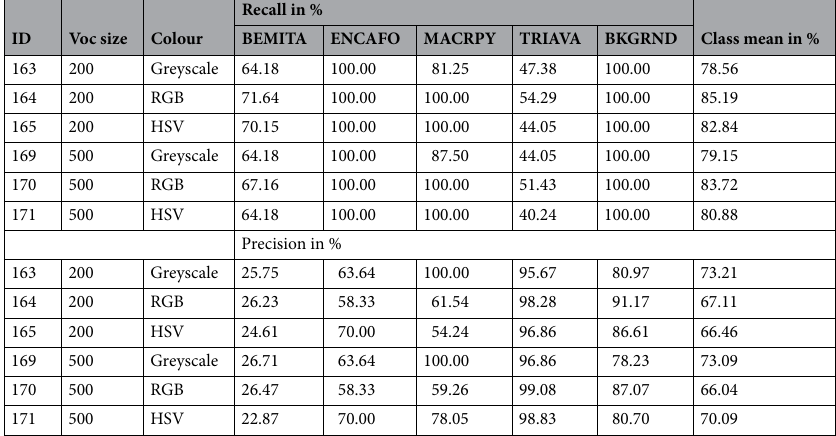
Table 5. Classification results with no pooling for training on the Lab0d-7d dataset and testing on the GH0d-7d dataset.